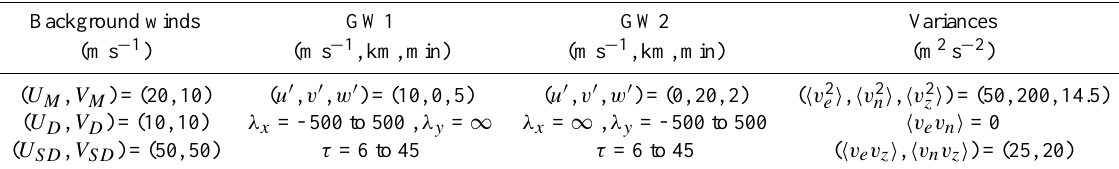
Background winds GW1 GW2